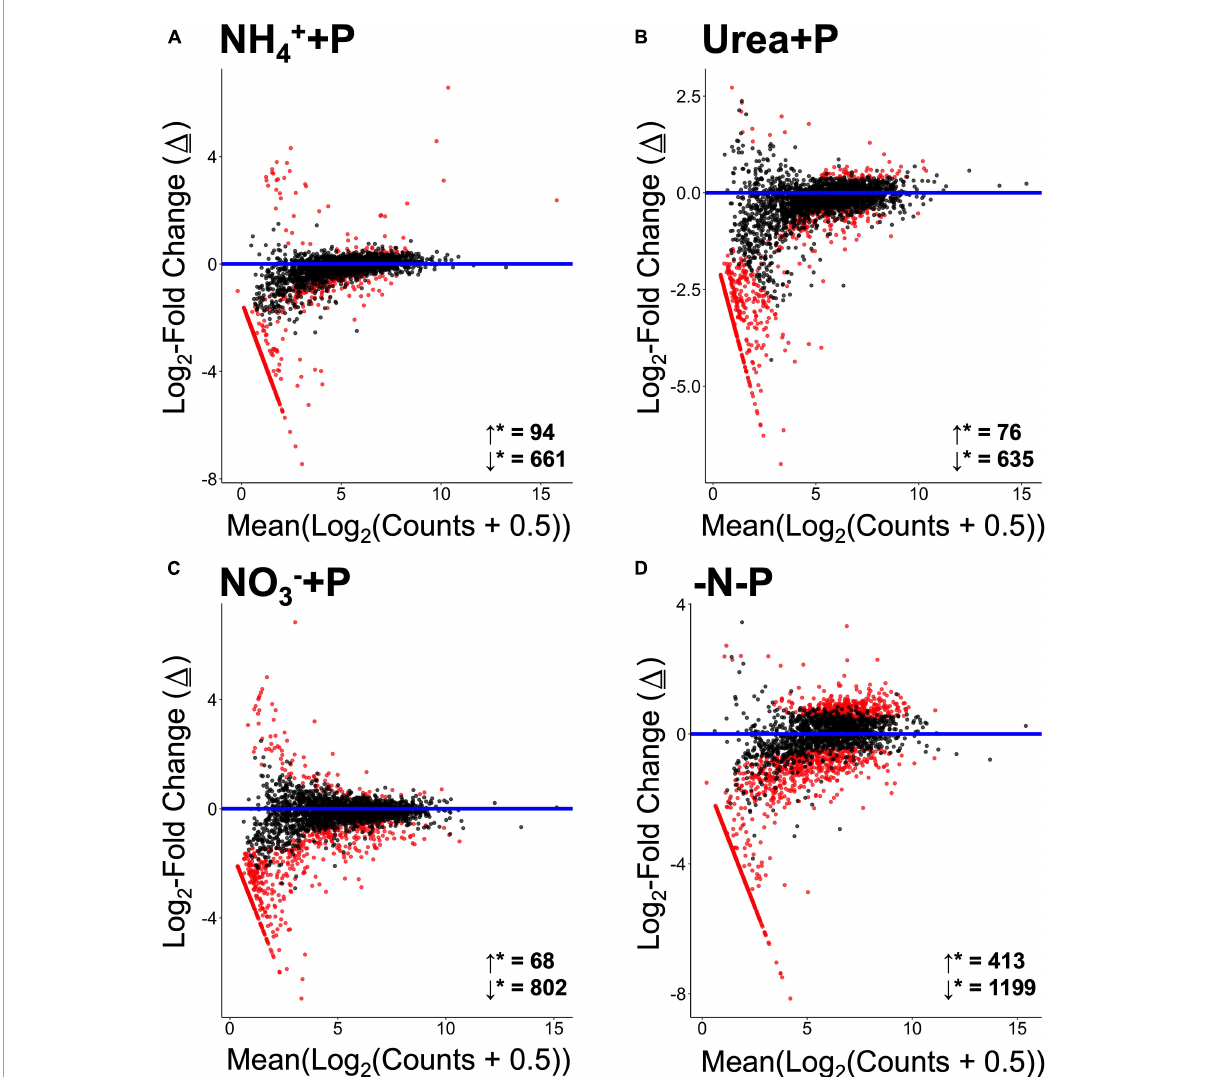
FIGURE6 MA plots representing log 2 -fold changes ( (cid:49) ) in gene expression of experimental treatments [ (A) = NH 4 + + P, (B) = Urea + P, (C) = NO 3 − + P, (D) = − N-P) relative to the control ( − N + P). Change is plotted relative to base mean expression of gene transcripts normalized, log 2 -transformed, annotated and aggregated relative to KO numbers. Significantly differentially upregulated ( ↓ *) genes and downregulated ( ↓ *) genes are indicated directly above the x-axes. Gene transcripts exhibiting statistically significant differences in expression (False Discovery Rate/ qval < 0.05) are colored red. Statistical analyses were performed in Sleuth using the Wald